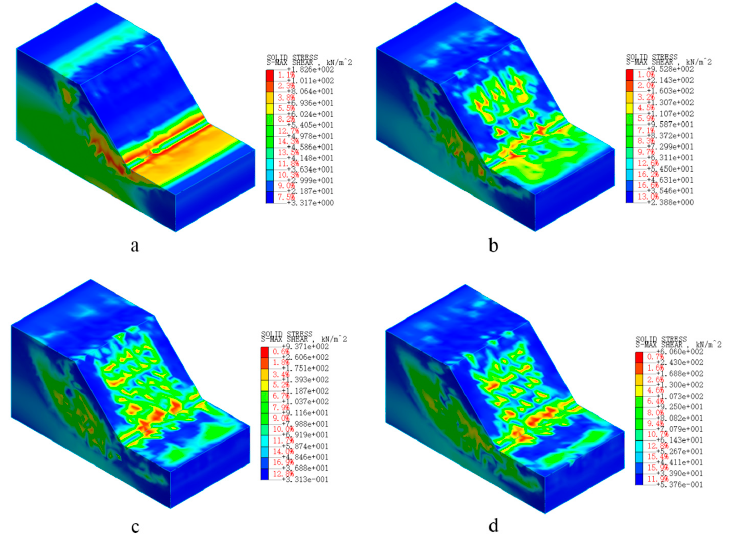
Figure 13. The shear stress of the slope: ( a ) The bare slope, ( b ) 2 m tap root, ( c ) 3 m tap root, ( d ) 4 m tap root.